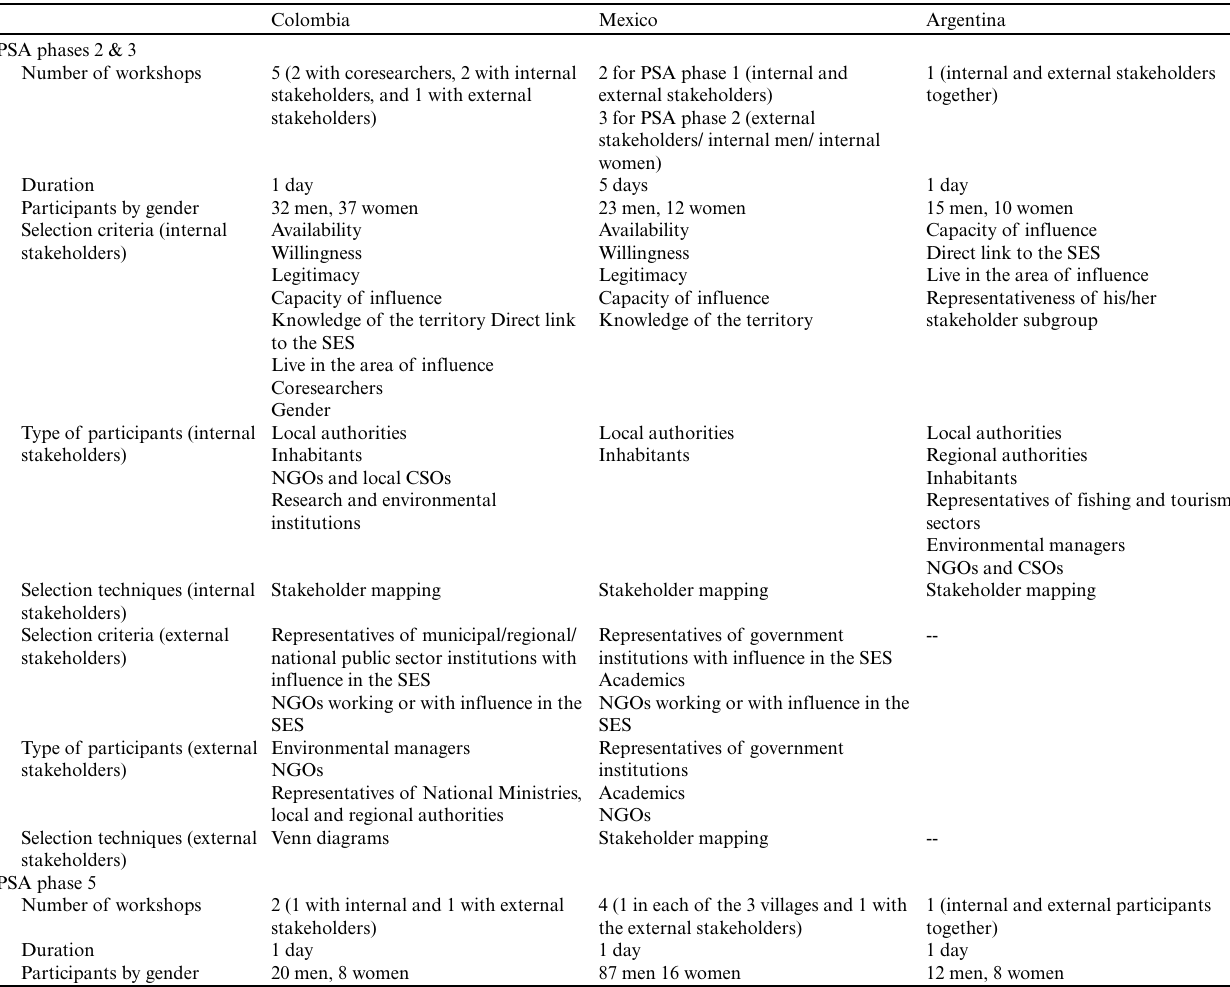
Table 2 . Workshop organization and participant